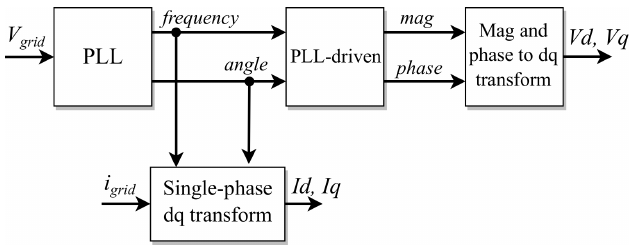
Figure 7. Basic schemes of PLL and dq